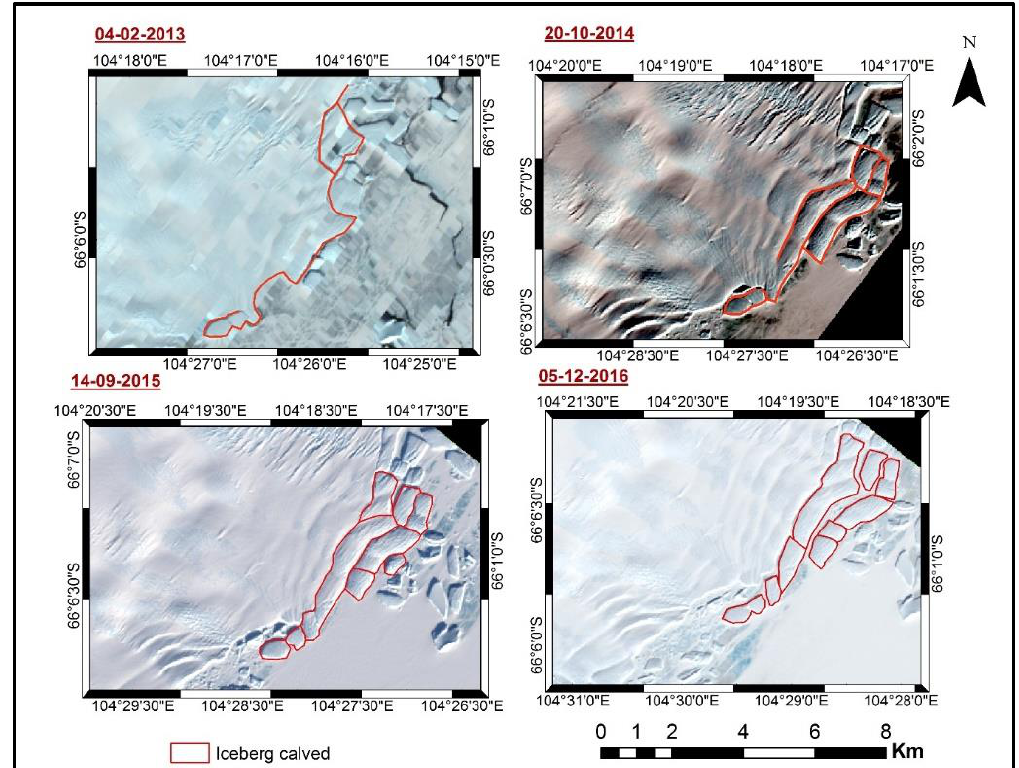
Figure 3. Calving event at Knox